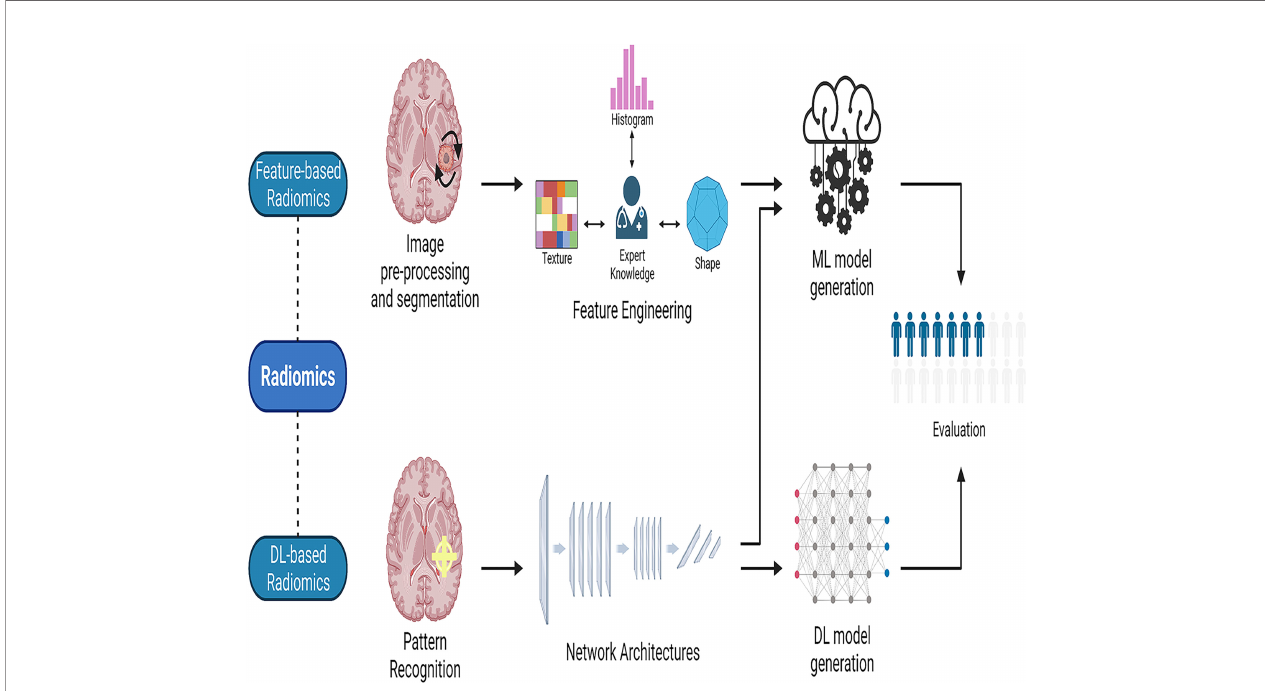
FIGURE 2 | The work fl ow of radiomics. Radiomics may be divided into two categories: feature-based radiomics and deep learning-based radiomics. The work fl ow for feature-based radiomics begins with image preprocessing, tumor segmentation, feature extraction, and feature selection, and concludes with the construction and assessment of a mathematical model. In deep learning-based radiomics, different network architectures are used to fi nd the most relevant features from the input data. Finally, the retrieved features can be processed further by the network for analysis and classi fi cation, or they can leave the network and used to generate models in a manner similar to the feature-based radiomics technique by employing different classi fi ers. ML, machine learning; DL, deep